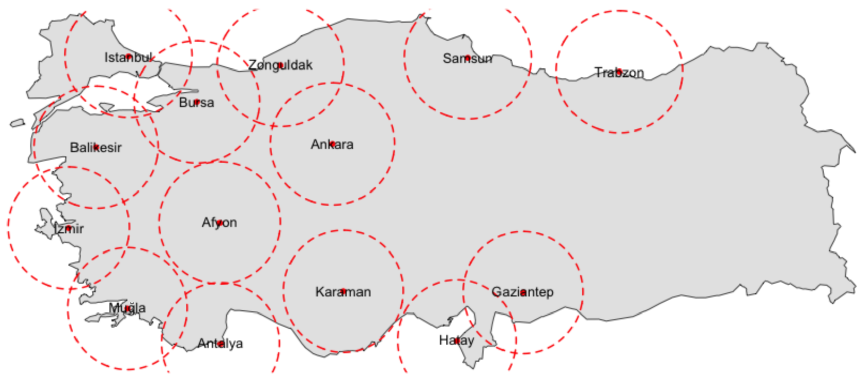
Figure 2. The distribution of 14 radar networks over Turkey. Precipitation products of six radars (Istanbul, Bursa, Balikesir, ˙Izmir, Muˇgla, and Afyon), which were taken from the TSMS, were evaluated manually to describe the characteristics of the precipitation